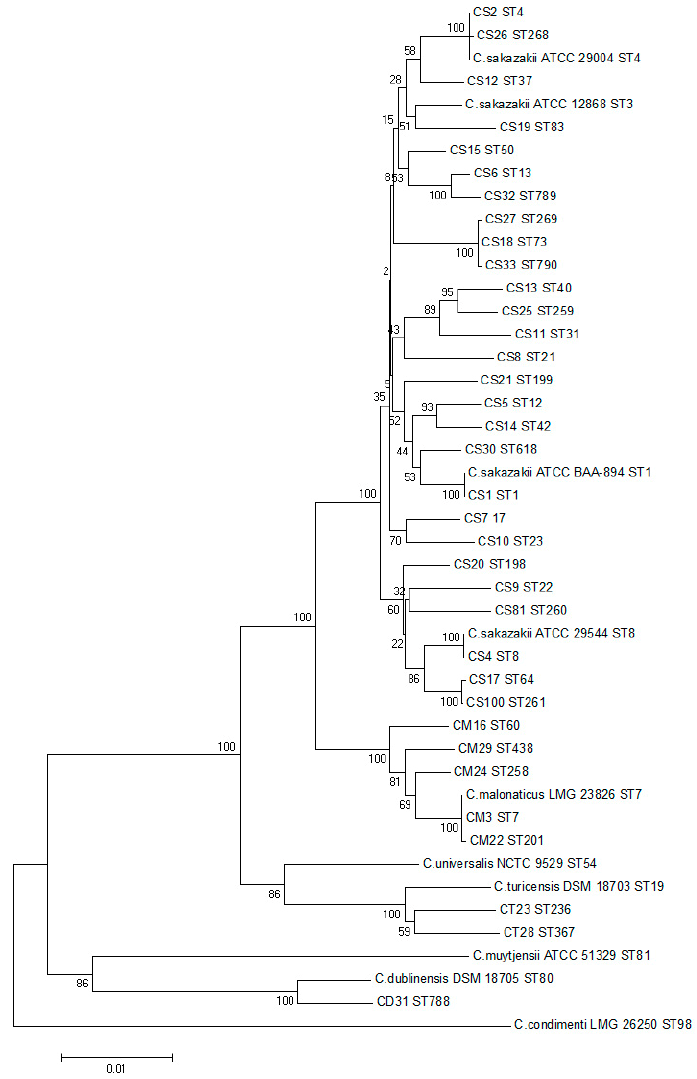
Figure 2. Phylogenetic tree based on the different ST type housekeeping genes .